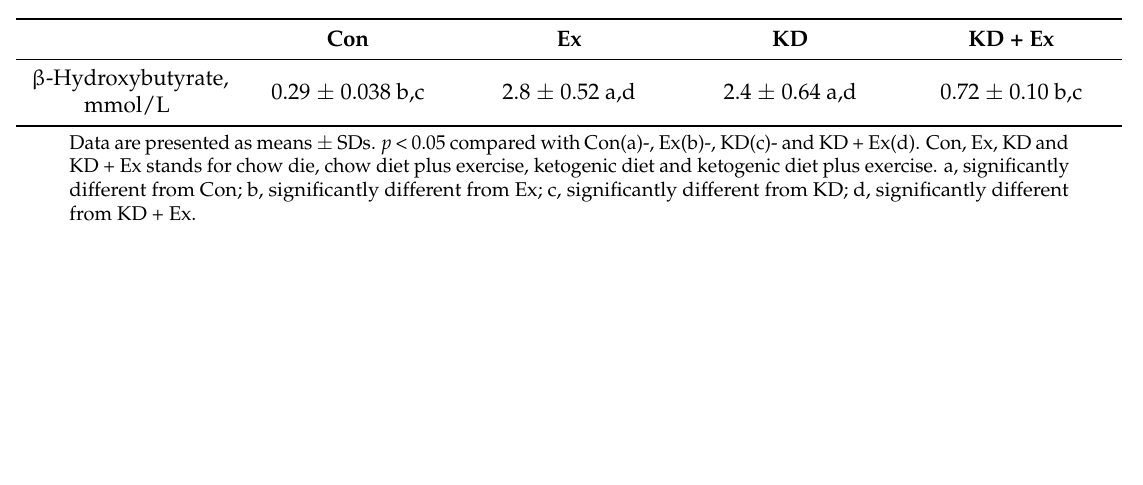
Table 1. Effect of KD feeding and/or exercise on β‐ Hydroxybutyrate concentration.